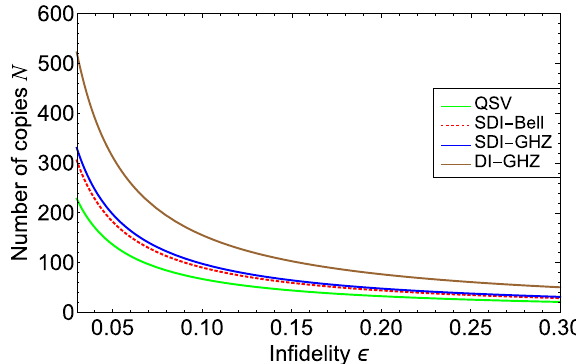
Fig. 4 Sample complexities for verifying the Bell state and GHZ states in three different scenarios. In standard QSV, the Bell state and GHZ states can be veri fi ed with the same sample complex- ity 42,57 . In the SDI scenario, the isotropic protocol is chosen for verifying the Bell state and the optimized equator + Z protocol is chosen for verifying the GHZ states. In the DI scenario, the Mermin inequality is employed for verifying the three-qubit GHZ state 46,50 . Here the signi fi cance level is chosen to be δ =